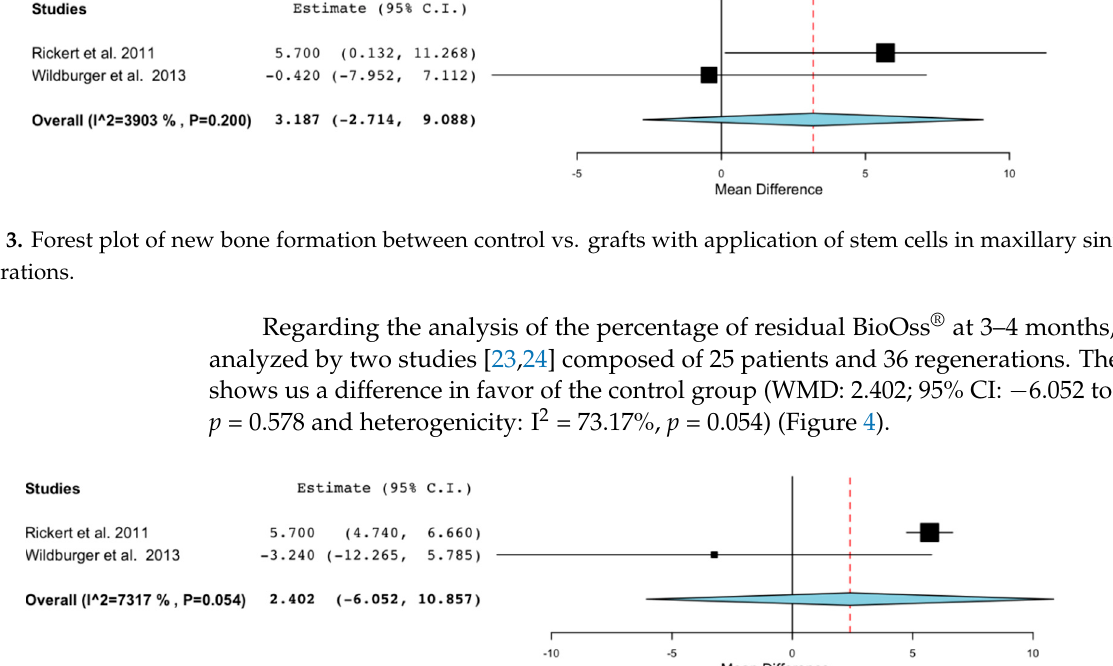
Figure 4. Forest plot of the residual content of biomaterial between control grafts vs. grafts with application of stem cells in maxillary sinus regenerations.